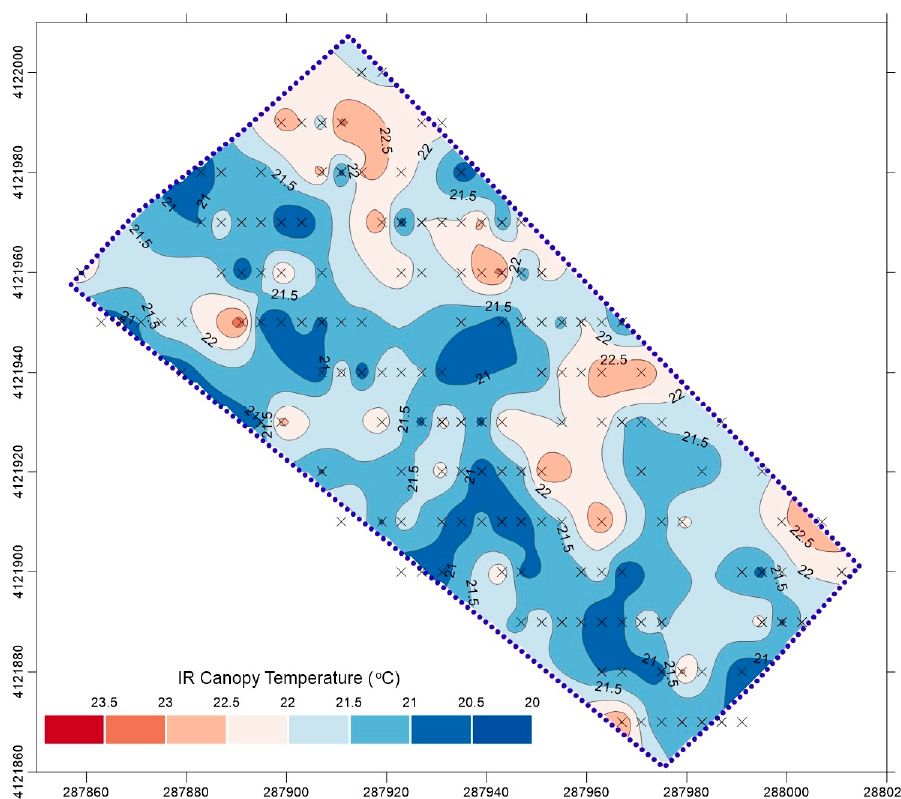
Figure 17. The temperature values that were derived from the IR sensor measurements.